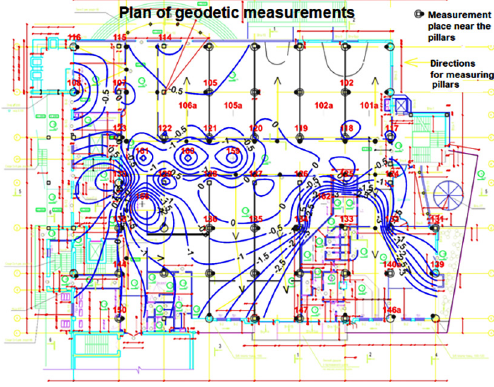
Figure 6. Isolines of vertical displacements of sedimentary marks of the first floor according to 1–13